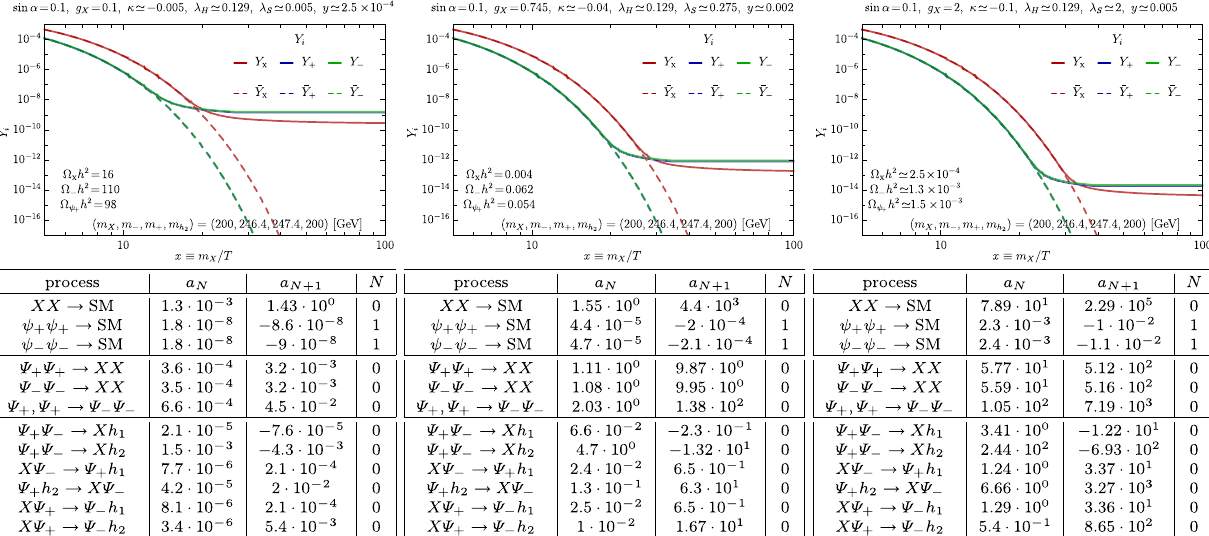
of thermally-averaged cross-sections (pb) expanded in powers of x − 1 , given by (cid:8) σ ijkl v M ∅ l (cid:9) = a N x − N + a N + 1 x − ( N + 1 ) + ··· . Note that